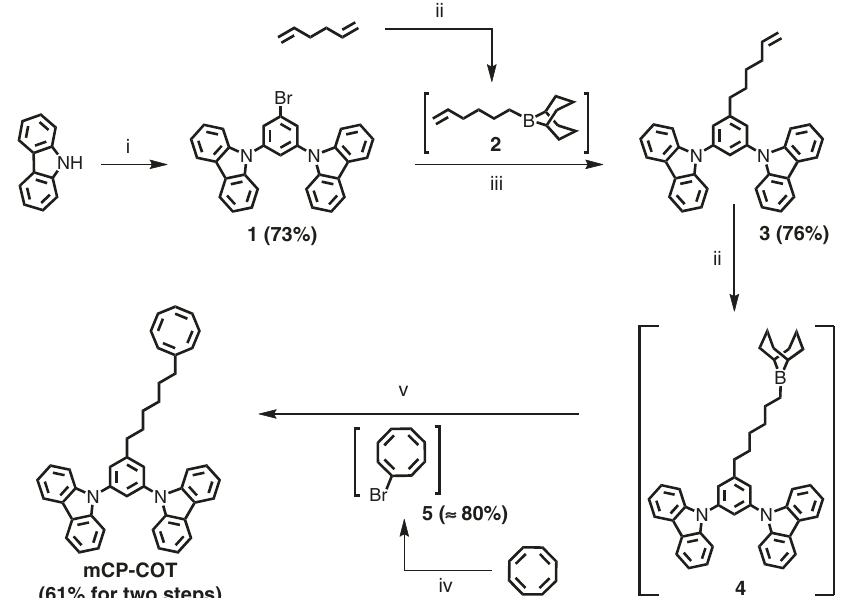
Fig. 1 Synthetic route to mCP-COT. (i a ) t BuOK, DMSO, Ar (g) , 120 °C, 0.5 h, b 1-bromo-3,5-di fl uorobenzene, Ar (g) , 140 °C, 0.5 h; (ii) 0.5 M 9-BBN in THF, Ar (g) , r.t., 2.5 – 3.5 h; (iii) 2 , K 2 CO 3 , Pd(dppf)Cl 2 .CH 2 Cl 2 , DMF, Ar (g) , 60 °C, 16 h; (iv a ) Br 2 , CH 2 Cl 2 , Ar (g) , − 70 °C, 1 h, b t BuOK, THF, Ar (g) , − 60 °C, 3 h; (v) 5 , K 2 CO 3 , Pd(dppf)Cl 2 . CH 2 Cl 2 , DMF, H 2 O, Ar (g) , 55 – 60 °C, 17 h (DMSO: dimethyl sulfoxide; THF: tetrahydrofuran; dppf: bis(diphenylphosphino)ferrocene; DMF: